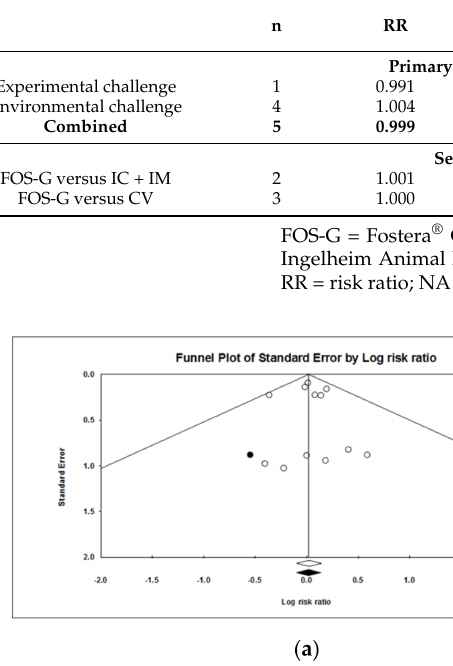
Table 4. Results of meta-analyses, evaluating the comparative efficacy of Fostera ® Gold PCV MH (FOS-G, Zoetis) on the relative risk of being classified as full market pigs or culls. Market Classification